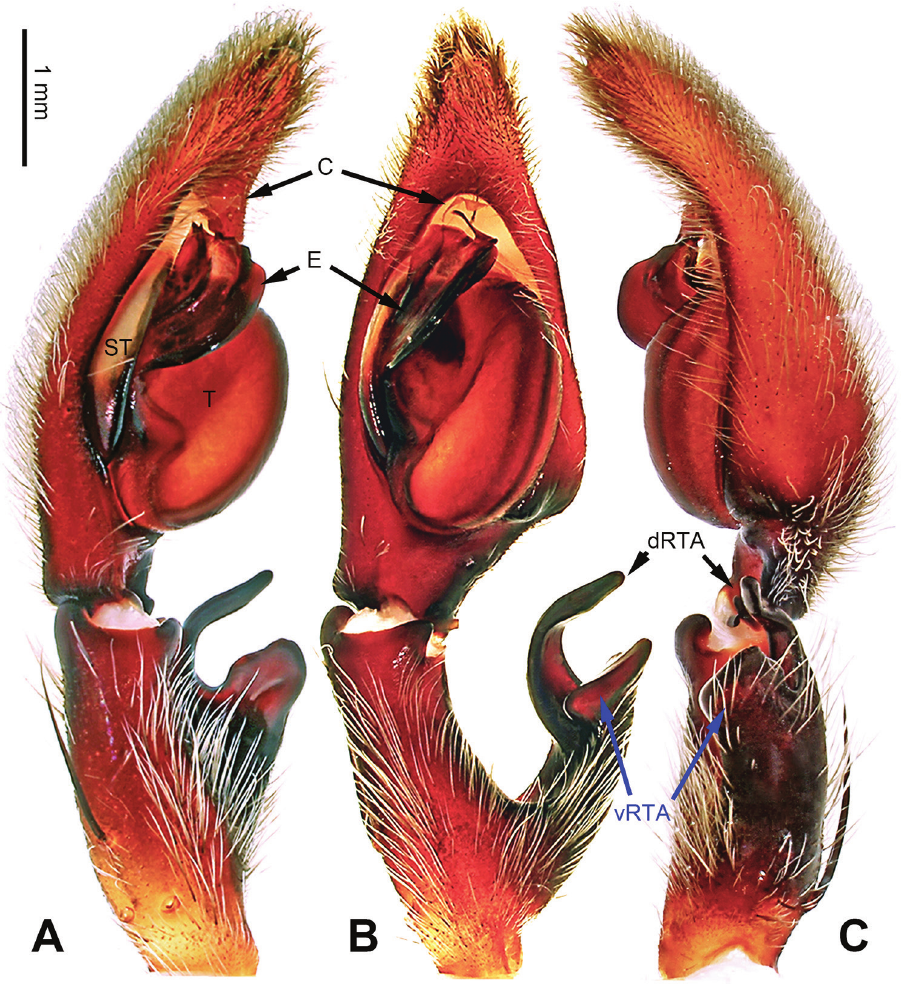
Figure 28. Pseudopoda titan Zhao & Li, sp. n., left palp of male holotype. A Prolateral view B Ventral view C Retrolateral view. Scale bar equal for A, B, C